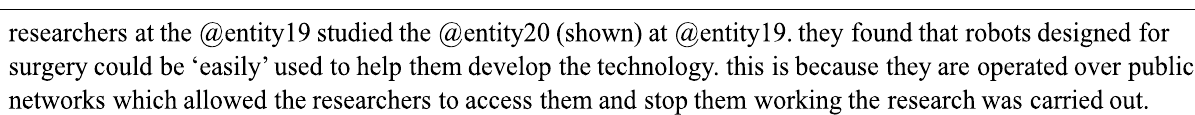
Fig. 2 An example of summaries toward a piece of news. From top to down, the first is the Source Document which is the raw news con- tent. The second is the Golden Summary which is used as the refer- ence summaries. The third is the summary generated by our proposed